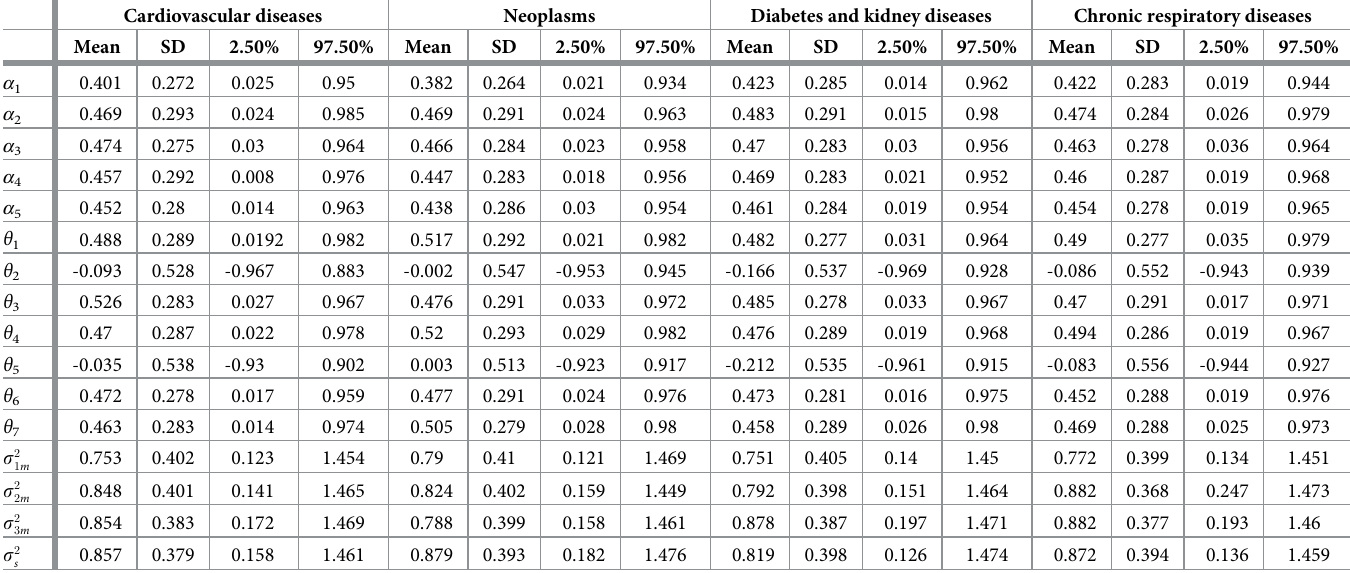
Table 4. Estimated parameters using Particle Independent